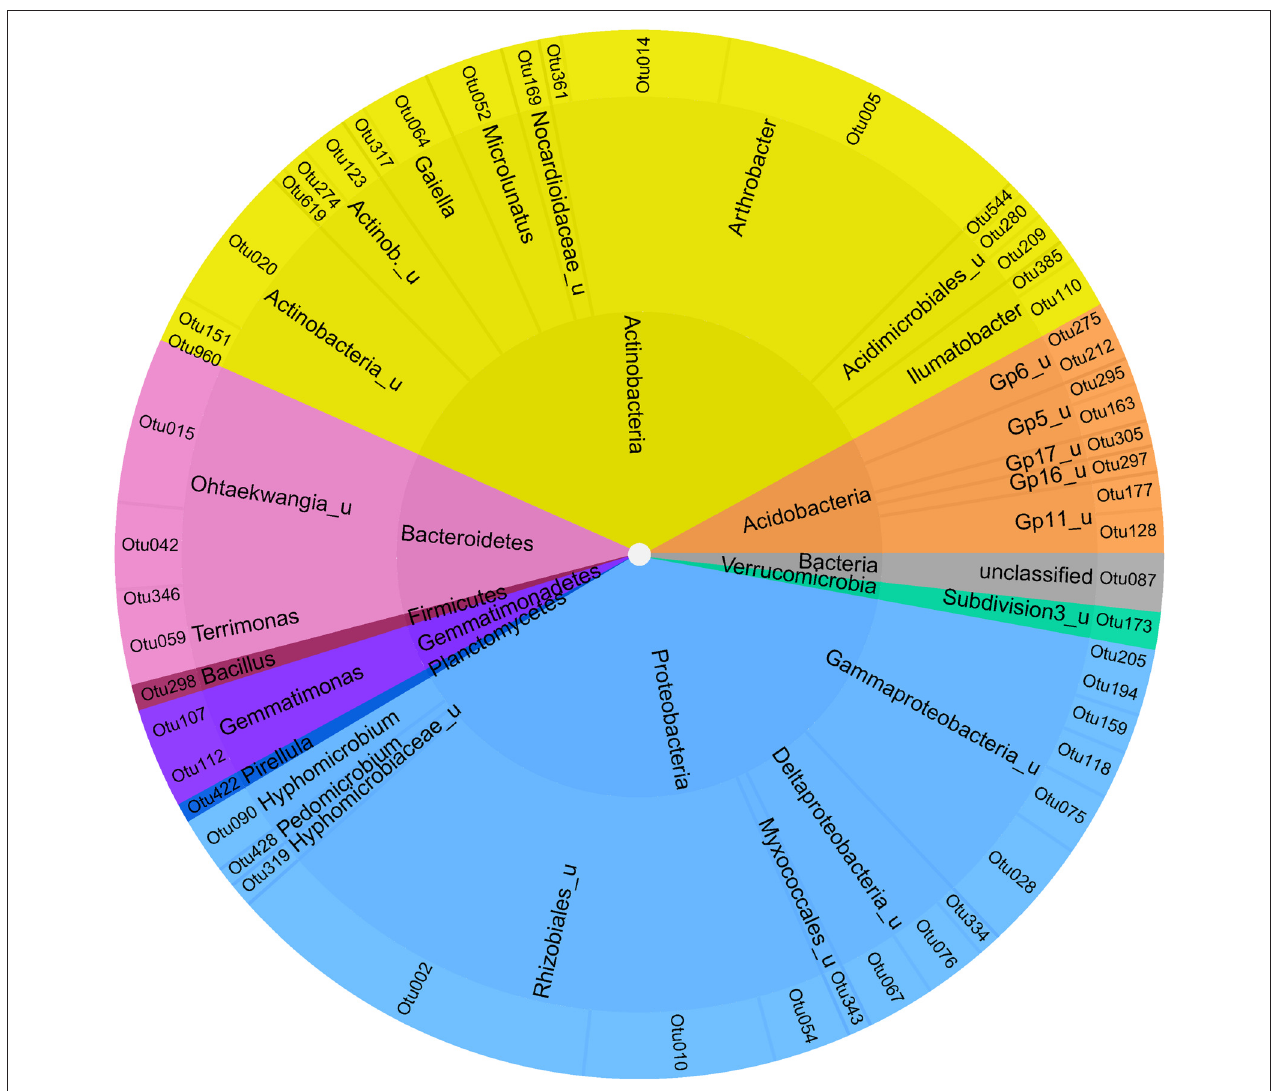
FIGURE 4 | Soil-intrinstic bacterial core microbiome. Inner ring—phylum level; middle ring–next classifiable level—outer ring level of individual